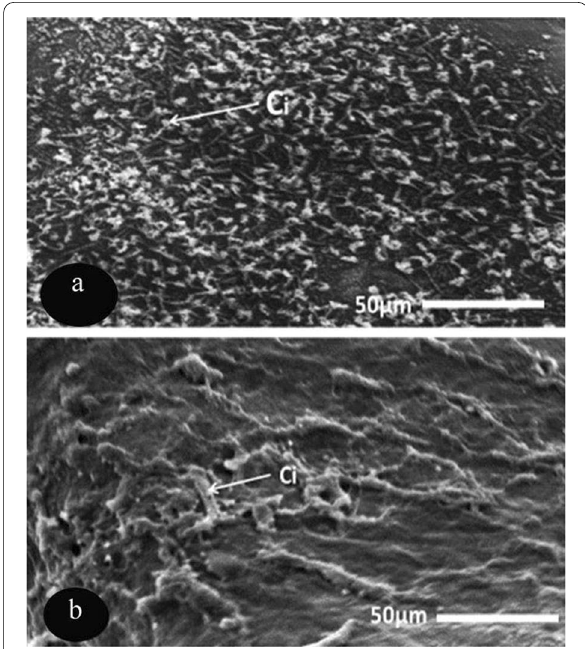
Fig. 5 SEM micrograph of the corneal epithelial cells of a Eudocimus albus b Anas platyrhuncus showing: Cilia (Ci) (Scale bar, 50 µm)